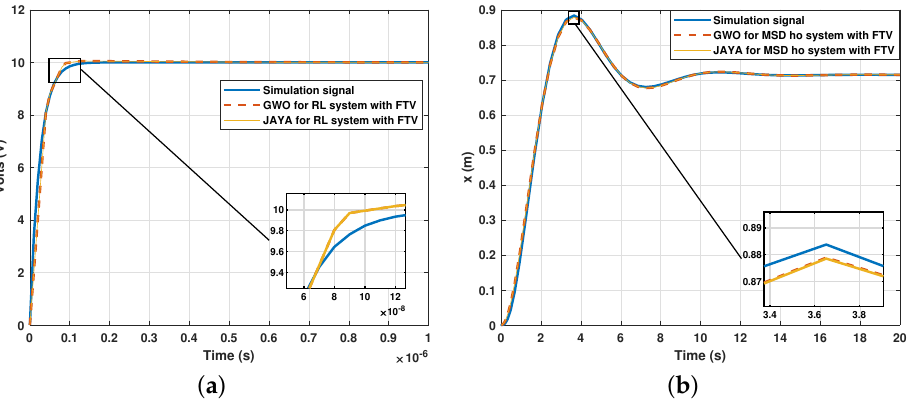
Figure 12. Result for different order systems via metaheuristic algorithms using FTV: ( a ) First order system (RL circuit); ( b ) High-order system (MSD